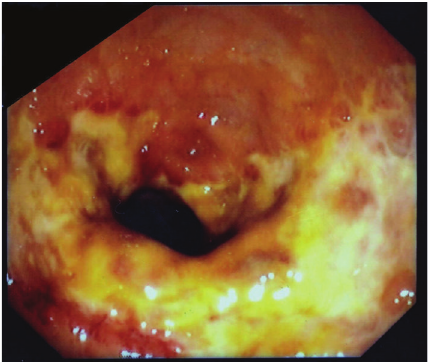
Figure1:Twodaysaftertheadmission.Thelumenoftherectumwas partially obstructed by a huge ulcerating rectal mass, 3-4cm above the dental line.